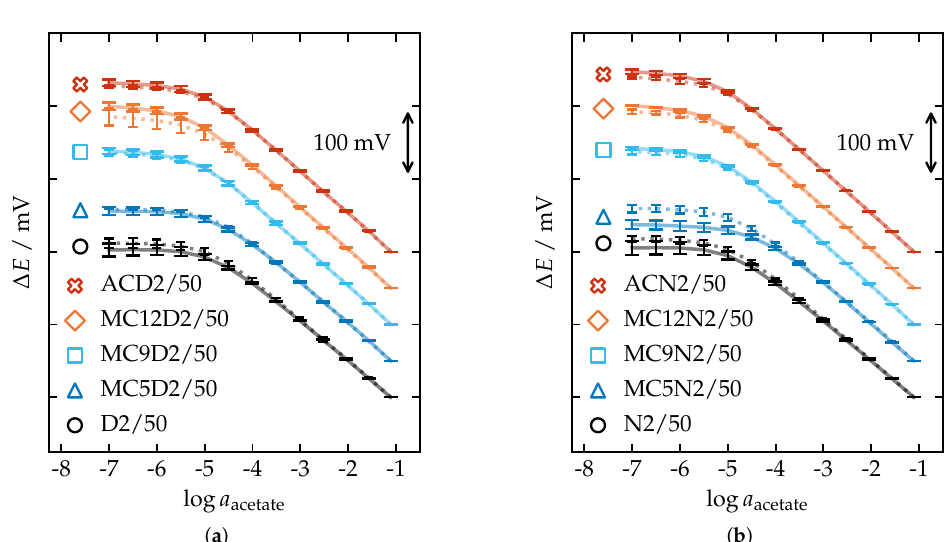
Figure A4. Potentiometric calibrations of sensors with membranes containing 2wt.% ionophore, 50mol.% (relative to the ionophore) TDMACl, and either ( a ) DOS or ( b ) o -NPOE as the plasticizer. Potentials have been adjusted to separate membranes and so that each sensor in a group starts at the same potential at log a = − 1.11. Error bars express standard deviations. PVC- and PCTFE-shelled sensors are shown as solid lines with wide error bars and dotted lines with narrow error bars, respectively. See Table 1 for membrane compositions.